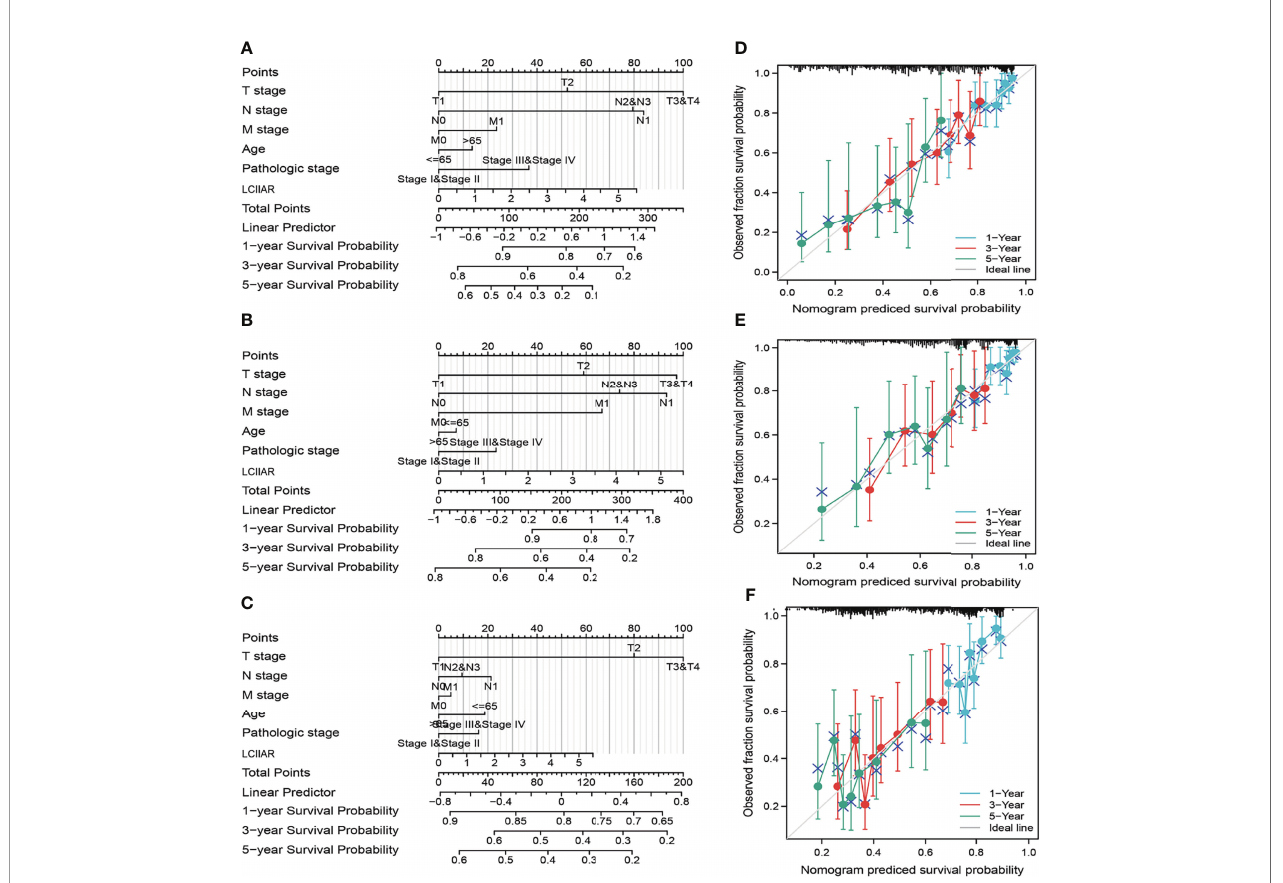
FIGURE 5 | Construction and performance validation of the LCIIAR based nomogram for LUAD patients. (A – F) Nomogram to predict the prognosis for lung cancer